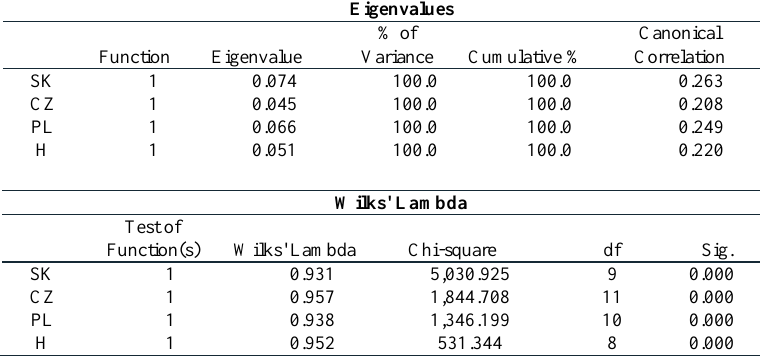
Table 4. Summary of Canonical Discriminant